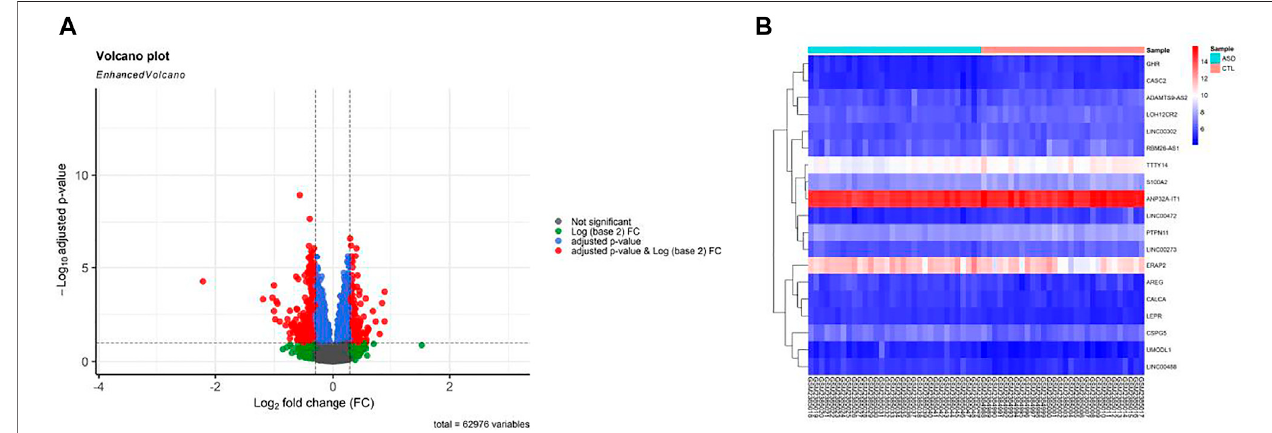
FIGURE2| Differentiallyexpressedgenes(DEGs)betweenautismspectrumdisorder(ASD)samplesandcontrol(CTL)samples. (A) VolcanoplotfortheDEGs. (B) Heatmapofimmune-relatedDEmRNAsandDElncRNAs.Highexpressedgenesareshowninred,whilethoseexpressedatlowlevelsareblue.TheDEGswerescreened according to a |(log2FC)| > 0.3 and an adjusted p -value < 0.01.